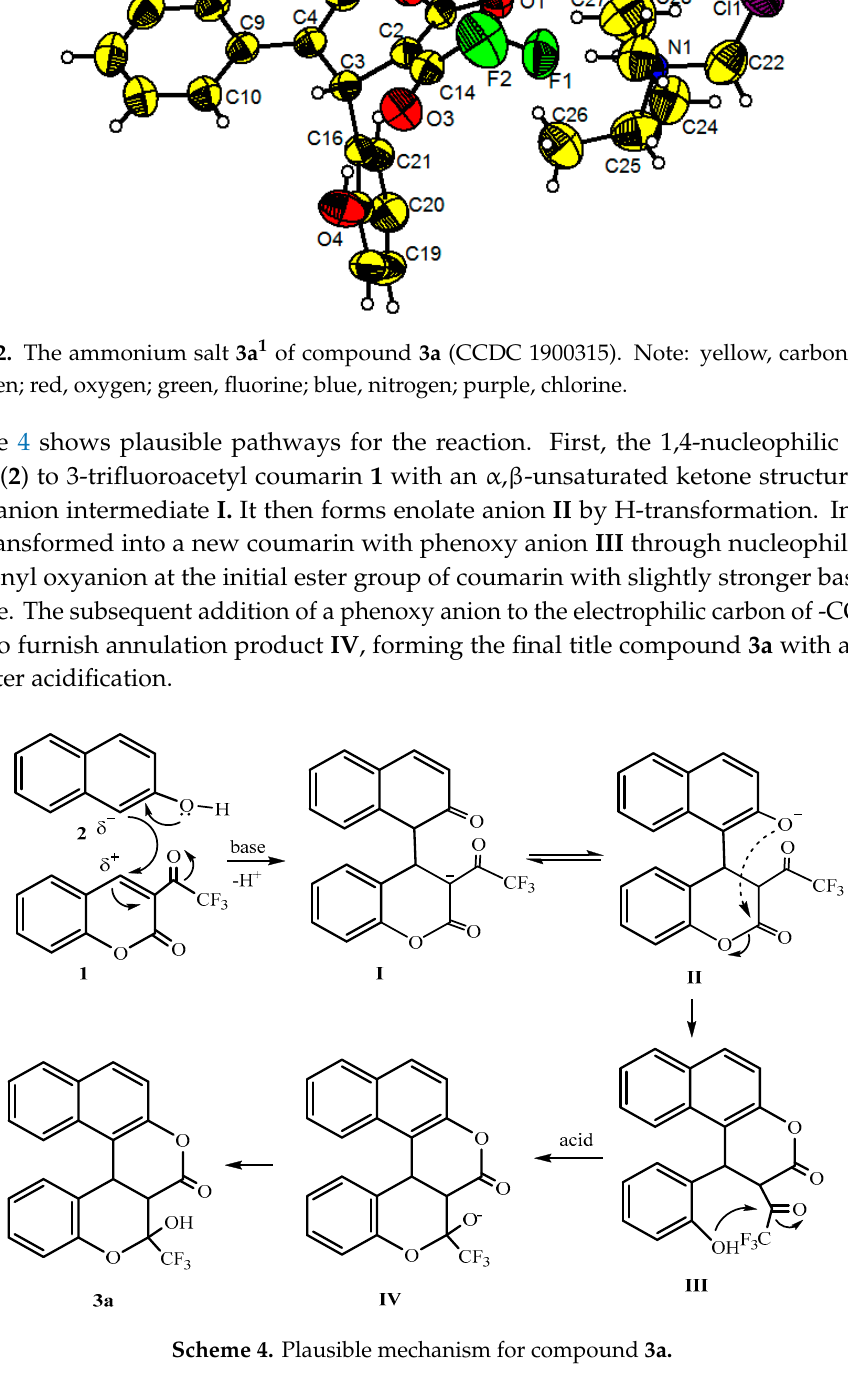
500 ppm ( b ) Figure 3. Antifungal activity of the target compounds 3 a – p , against— Fusarium graminearum ( a ) and Fusarium monitiforme ( b ) . The bioassay results for Fusarium graminearum indicated that, except for compound 3h, all the target compounds showed antifungal activities to some extent, with an inhibitory index in the